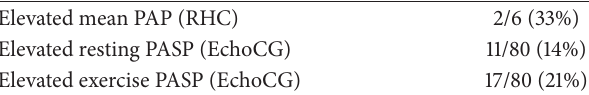
Table 3: PAH prevalence in RA ( 𝑛 = 80